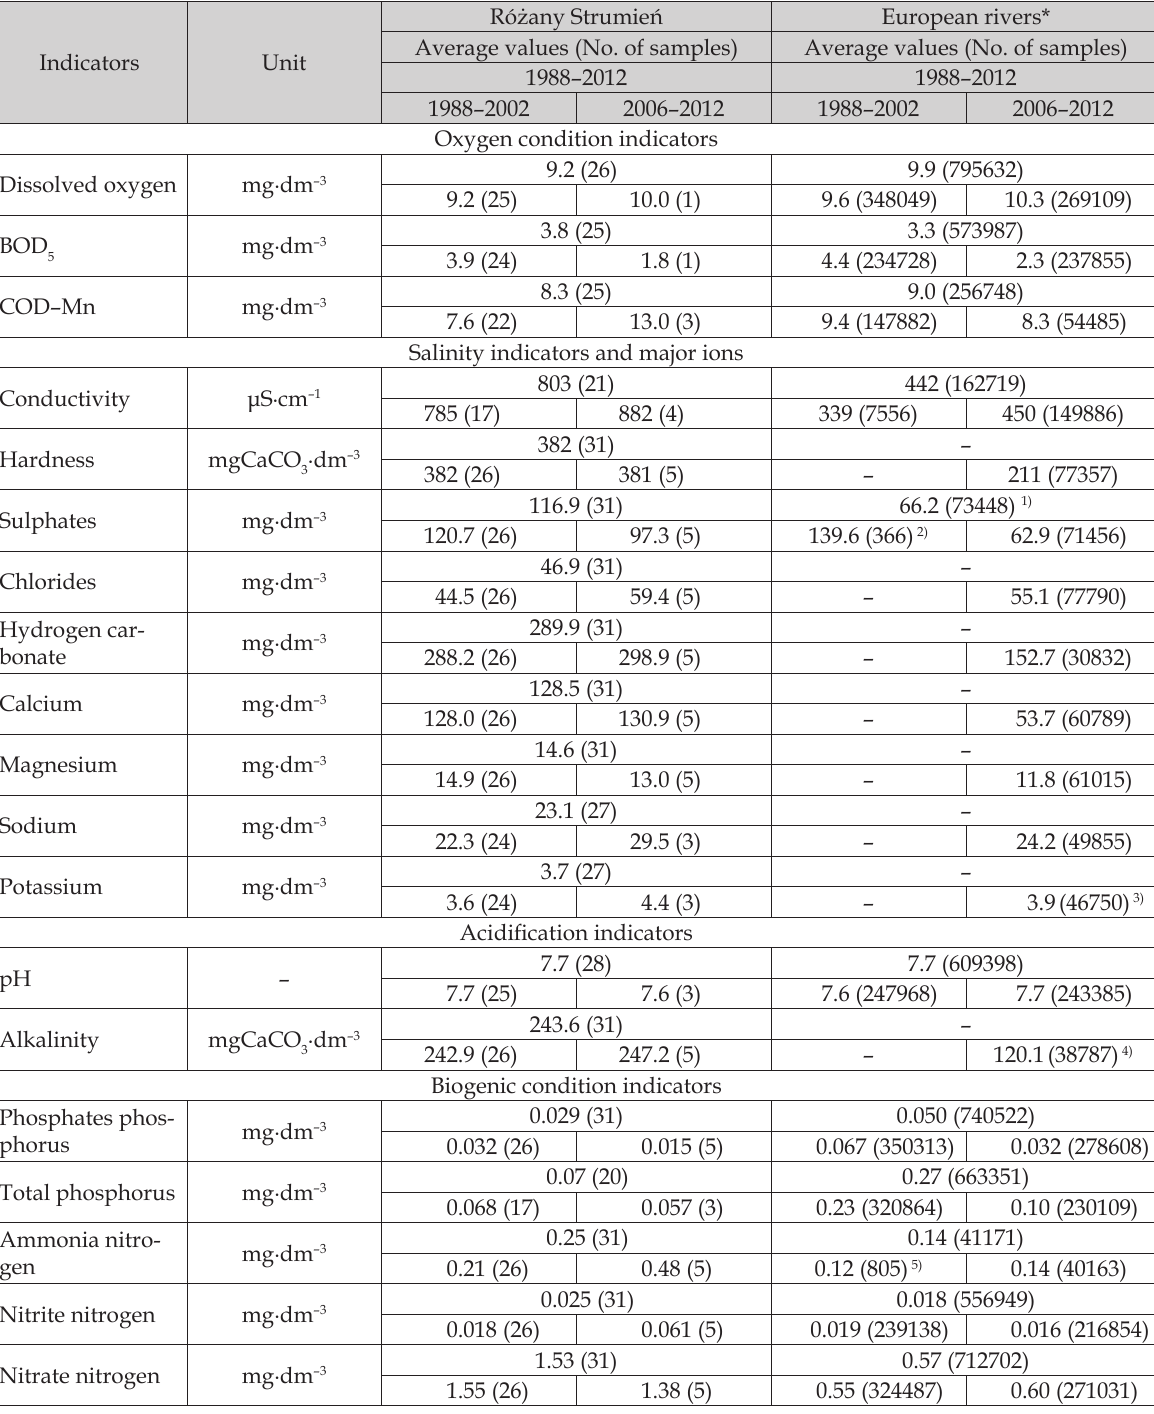
Table 4. Comparison of average chemical composition of river water in the years